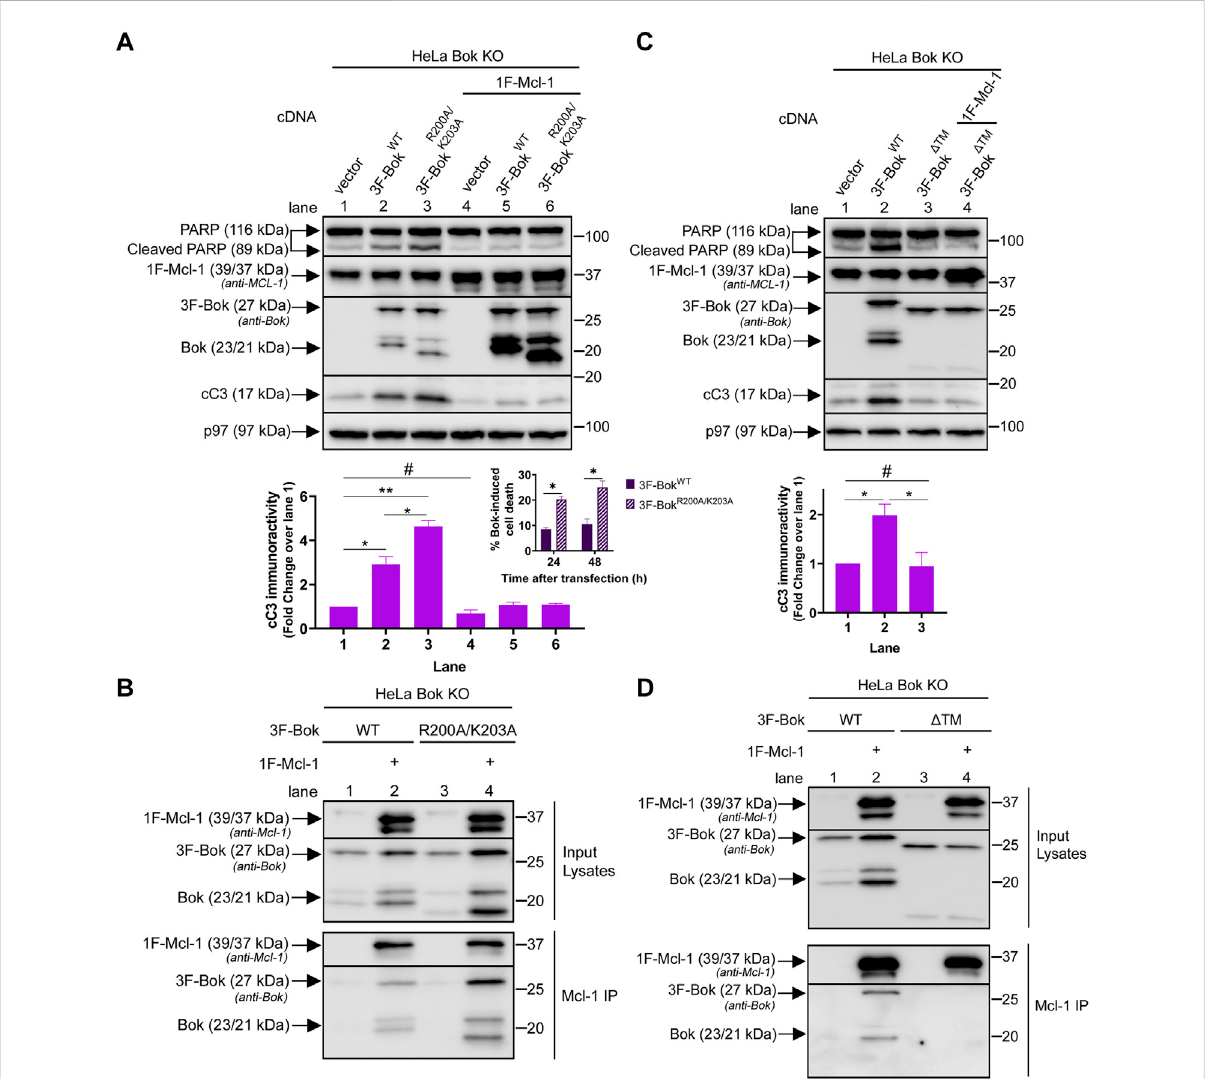
Effects of R200/K203 mutation on apoptosis induction in HeLa cells. (A,C) , Bok KO HeLa cells were transiently transfected with 3F-Bok constructs withoutor with 0.025 µg1F-Mcl-1 and samples were probed in immunoblots as indicated with anti-Bok to identify Bok species and anti- Mcl-1, to identify both endogenous human Mcl-1 (39 kDa) and exogenous mouse 1F-Mcl-1 (39/37 kDa). The histograms show quantitated cleaved caspase-3 (cC3)immunoreactivity(mean±SEM n =3,*designates p < 0.05, **designates p < 0.005and#designatesnotsigni fi cant, p > 0.05). The insert in panel (A) shows cell death induced by 3F-Bok WT and 3F-Bok R200A/K203A , 24 and 48 h post-transfection (mean ± SEM n = 2, * designates p < 0.05). (B,D) , Bok KO HeLa cells were transiently transfected with 3F-Bok constructs without or with 0.5 µg 1F-Mcl-1, anti-Mcl-1 IPs were performed and samples were probed in immunoblots as indicated. 3F-Bok Δ ™ generates Bok immunoreactive bands at ~25 and 18